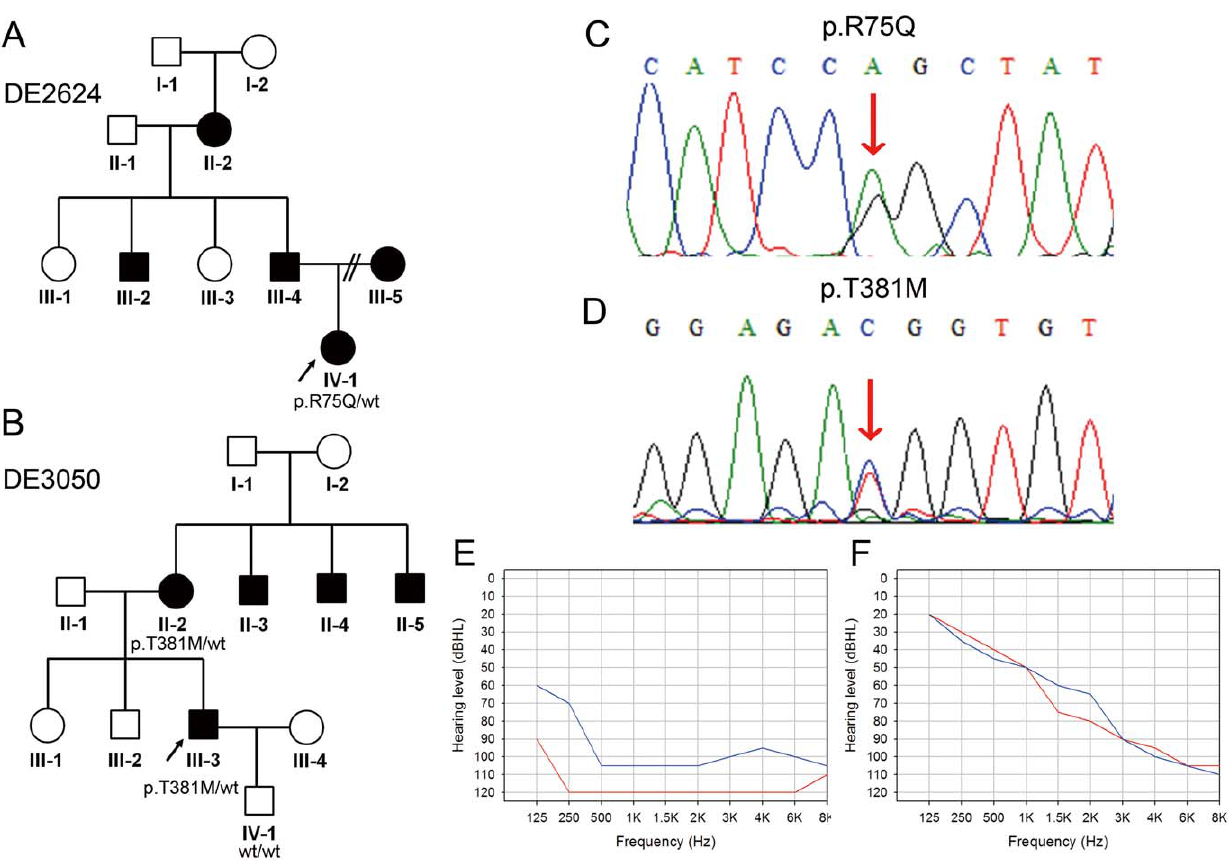
Figure 2. The GJB2 p.R75Q mutation in Family DE2624 and the MYO7A p.T381M mutation in Family DE3050. (A) Pedigree and segregation pattern in Family DE2624. (B) Pedigree and segregation pattern in Family DE3050. (C) Sanger sequence of the GJB2 p.R75Q mutation. Arrow: nucleotide change c.224G . A (p.R75Q) variant. (D) Sanger sequence of the MYO7A p.T381M mutation. Arrow: nucleotide change c.1142C . T (p.T381M) variant. (E) Audiogram of the proband of Family DE2624. (F) Audiogram of the proband of Family DE3050. Hearing levels of the right ear and left ear are marked with red and blue lines, respectively.